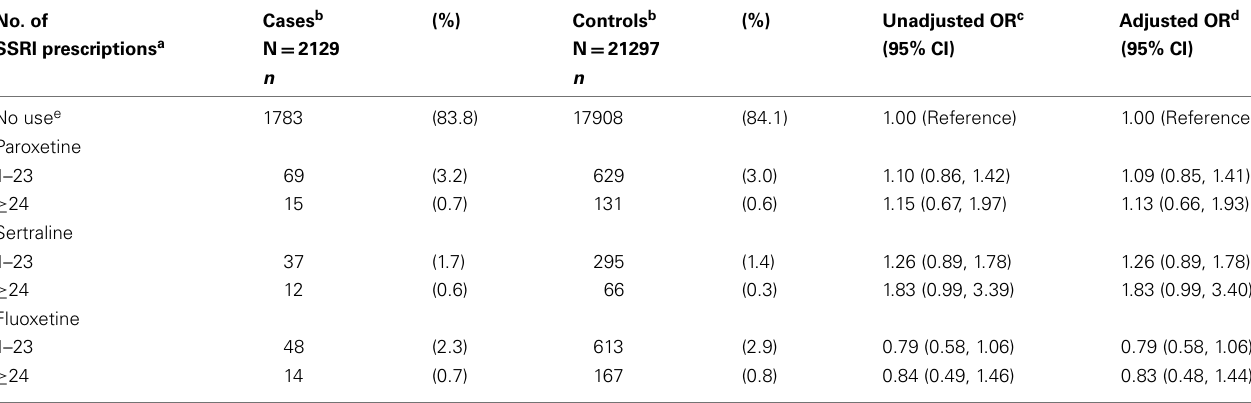
Table 5 | Odds ratios for breast cancer according to total “exclusive use” of each individual high inhibitor antidepressant agent. No.